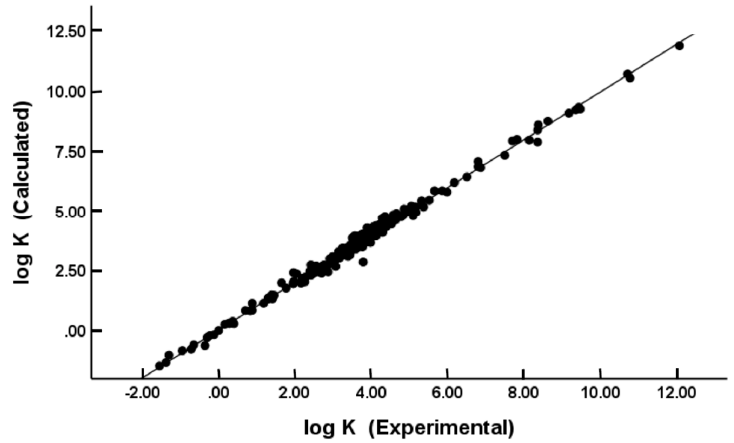
Figure 1. Comparison of observed log P PDMS-water data versus back-calculated values based on Equa- tion (11) for PDMS.